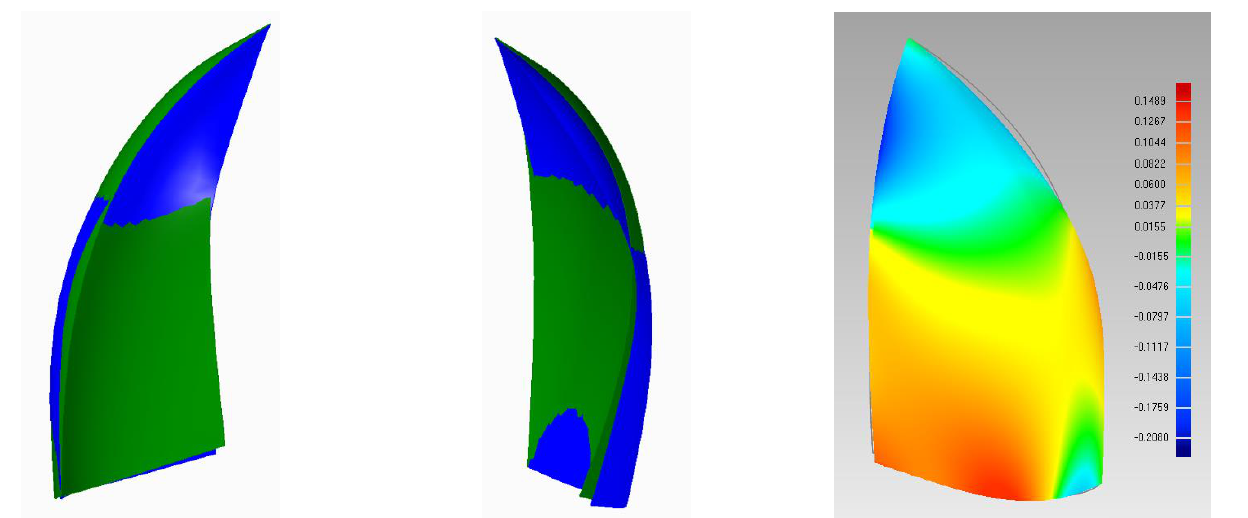
Figure 15. Design shape (green), flying shape (blue), and map of the 3D deviations [m] for AWA = 90° and Δ α g = 0°.